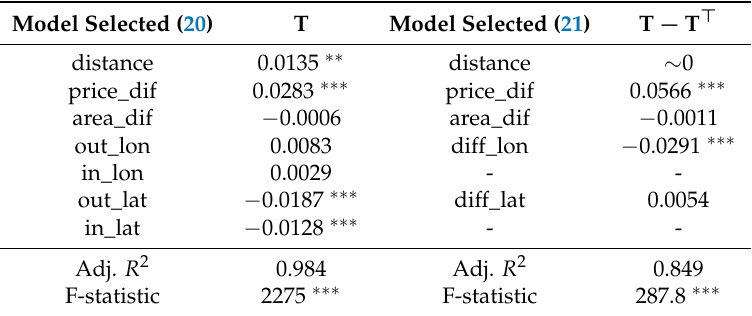
Table 5. Regression analysis for transition